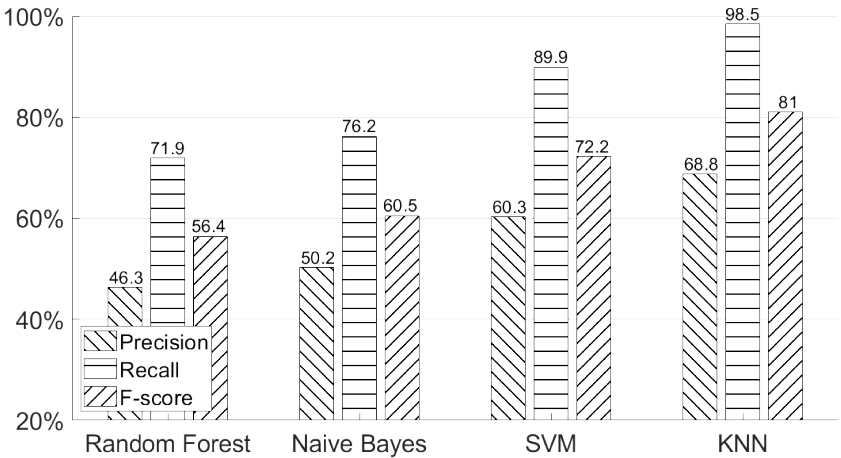
Figure 18. Authentication performances using different machine learning models—Random Forest, Naive Bayes, SVM and KNN.